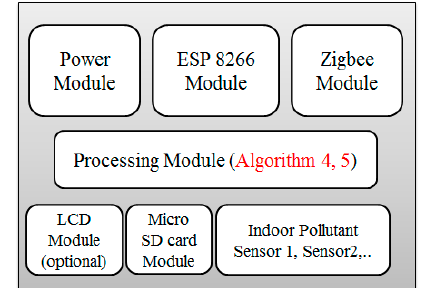
Figure 6. Edge computing device.